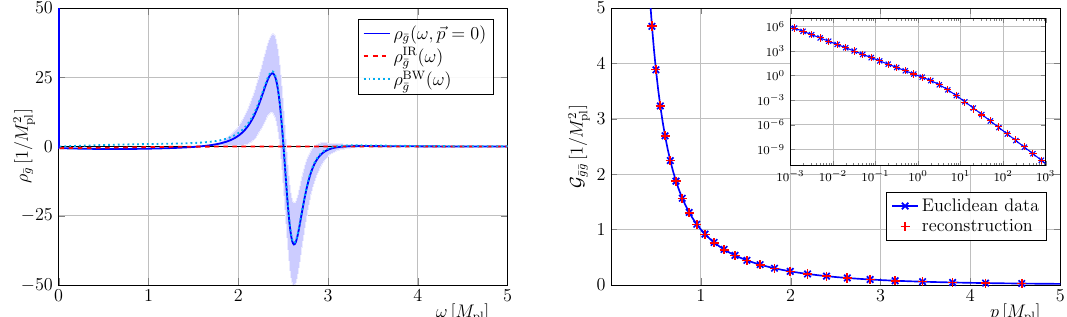
Figure 8: Spectral function of the background graviton and reconstructed Euclidean graviton propagator. The reconstruction, the definition of its error, and the error band in Sec.5.1 are described in Sec.5.1 and Sec.5.3. (left) Spectral function of the background graviton (blue, solid line). It features a δ -function at ω = 0 (massless ( ω ) . We also depict graviton), and an ensuing smooth multi-particle continuum, ρ cont ¯ g the IR asymptotics (red, dashed), and the Breit-Wigner part (cyan, dotted). (right) Euclidean background propagator reconstructed from the spectral function presented in the left panel. The reconstructed and original Euclidean data agree very well on all < 10 − 3 data points corresponding to a reconstruction error of E rel